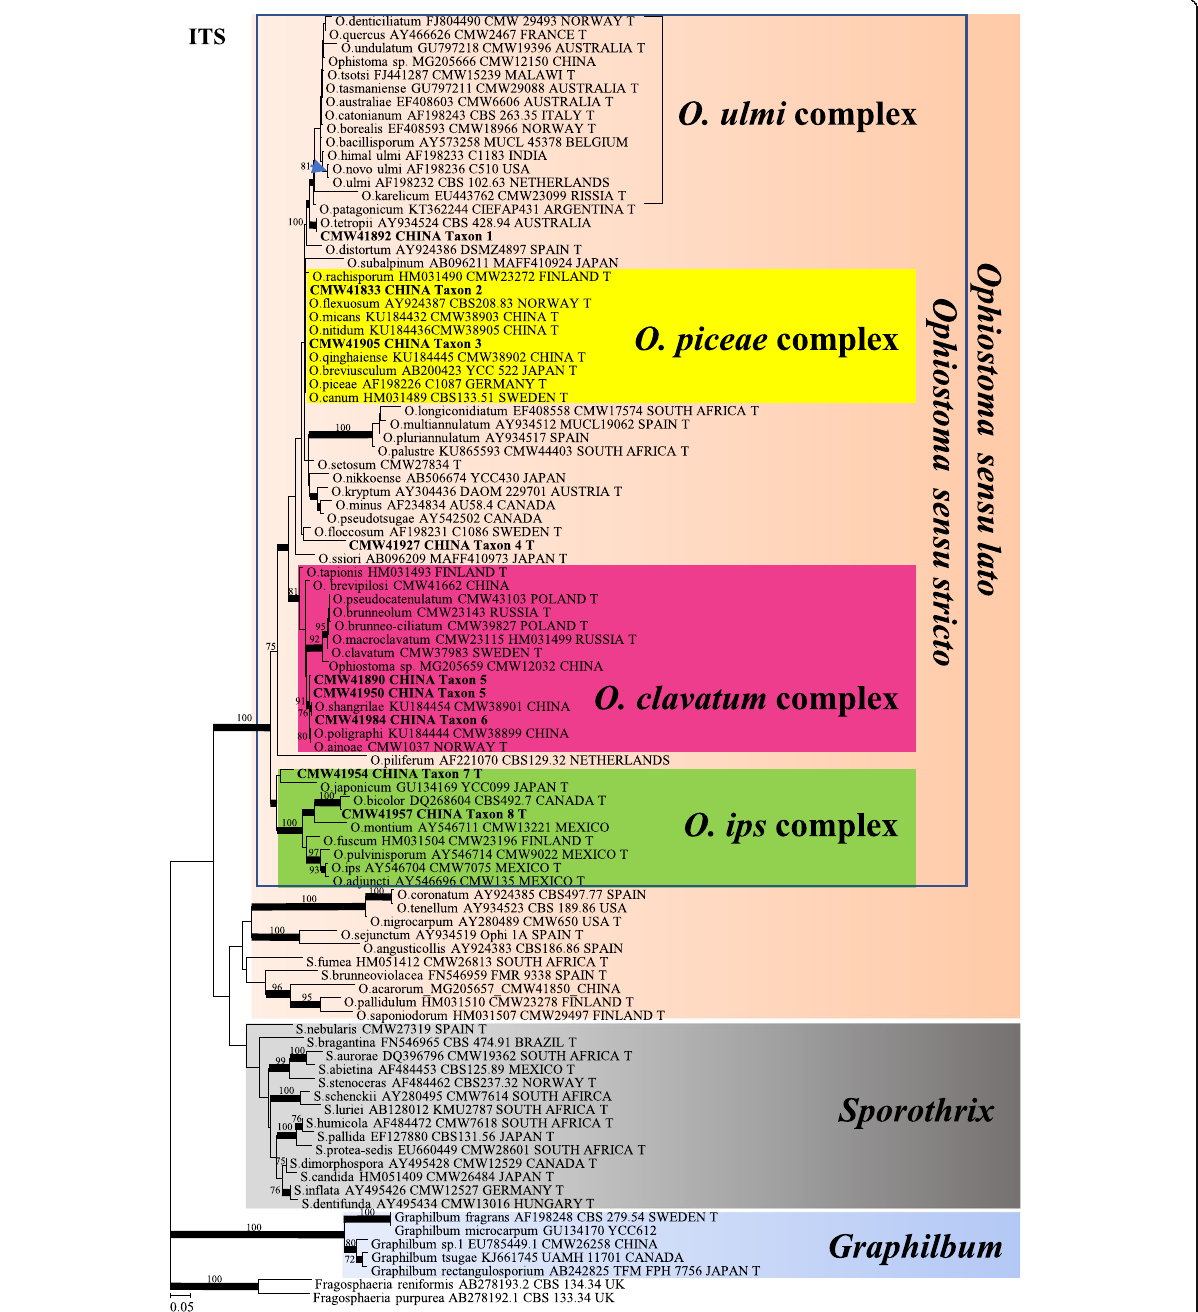
Fig. 1 Phylogram obtained from ML analyses of the ITS region of Ophiostoma . Sequences obtained in this study are printed in bold type. ML bootstrap support values (1000 replicates, normal type) above 75% are indicated at the nodes. Posterior probabilities (above 0.9) obtained from BI are indicated by bold lines at the relevant branching points. T = ex-type cultures. Scale bar = total nucleotide difference between